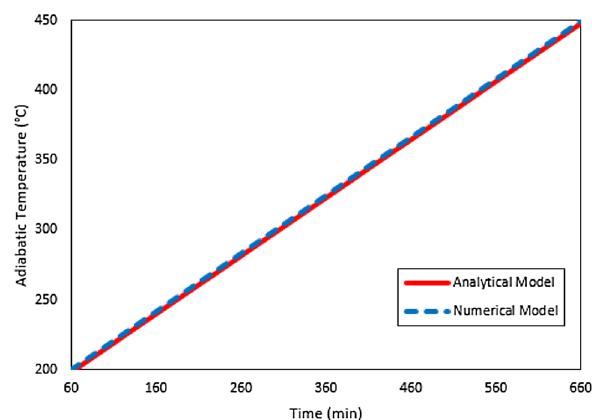
Fig. 11 Analytical and numerical model correlations for an adiabatic gas